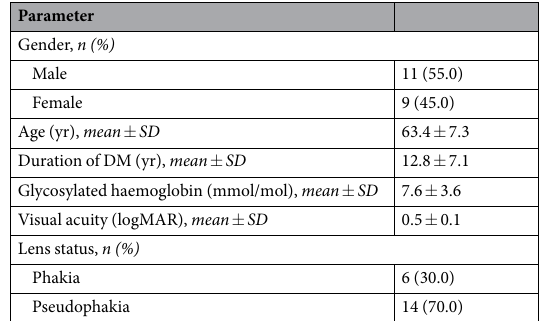
Table 1. Study Population characteristics (DME group; n = 20). Abbreviations: DM = diabetes mellitus; SD = standard deviation.